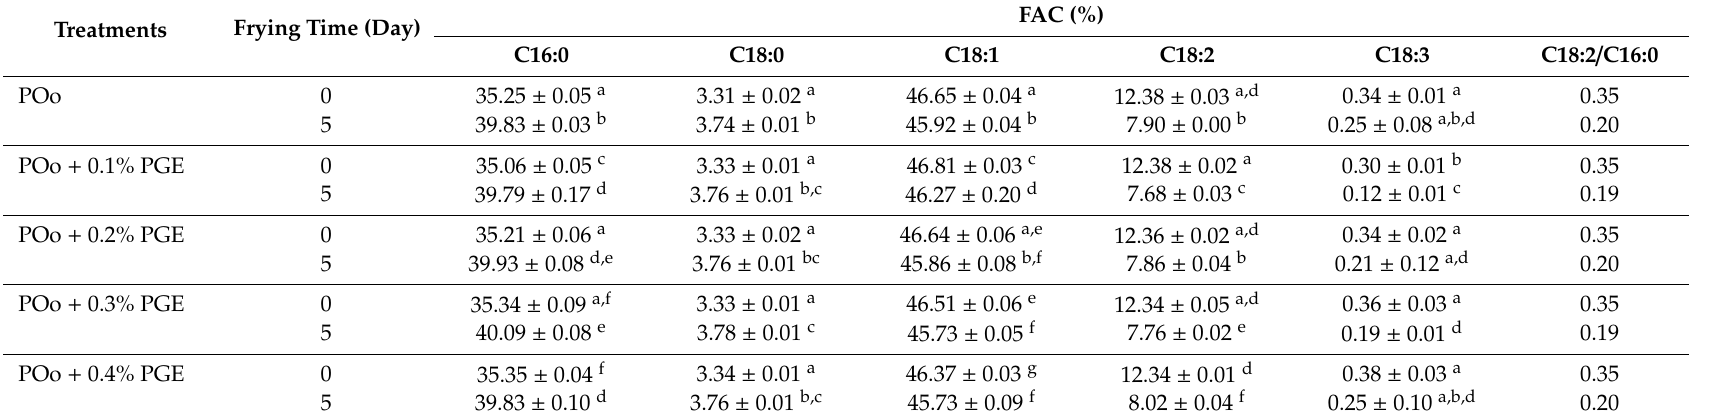
Table 3. Changes of FAC in POo added with PGE during repeated